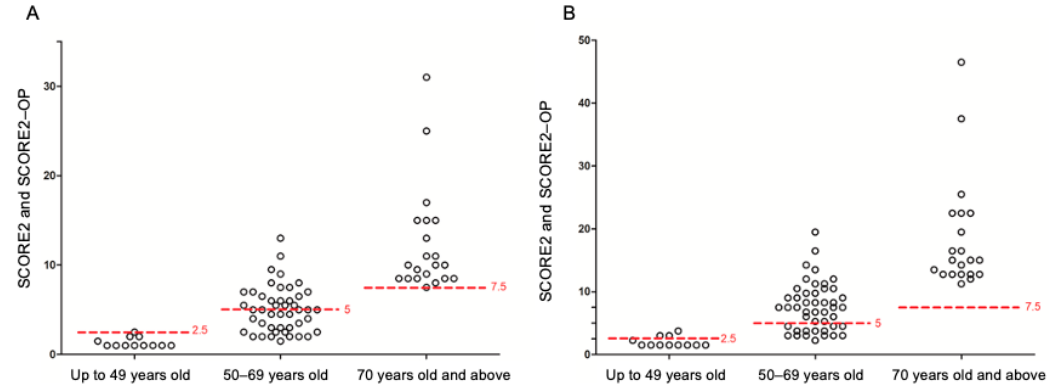
Figure 1. 10-year risk of fatal and non-fatal CV disease events calculated using the SCORE2 and SCORE2-OP risk prediction algorithms in the 79 eligible patients with primary Sjögren’s syndrome. Panel ( A ) shows the normal calculation as in the general population; panel ( B ) shows the values using a 1.5 correction factor as currently applied in rheumatoid arthritis. Dotted lines and adjacent numbers show the corresponding cut-off value by age.